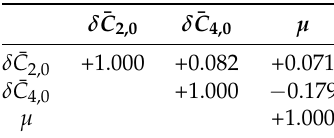
Table 3. Correlations among the three estimated quantities evaluated as solutions of Equations (7) for the GGM05S model.